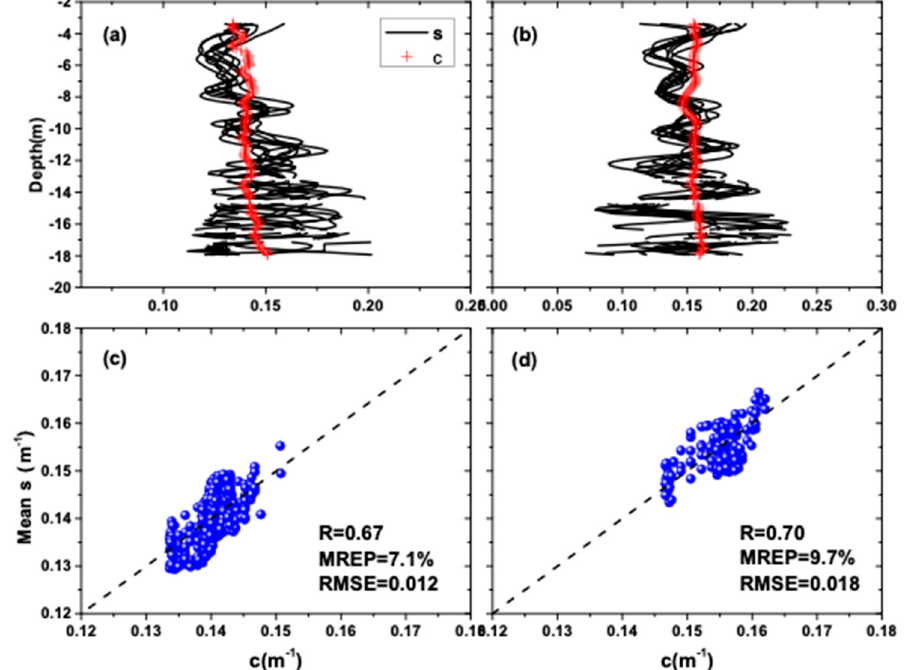
Figure 4. Comparison of airborne LiDAR-retrieved results with those by bio optical models. ( a ) and ( c ) are for Station S1 (109°48.158'E, 18°18.309'N); ( b ) and ( d ) are for Station S2 (109°48.981'E, 18°18.861'N).